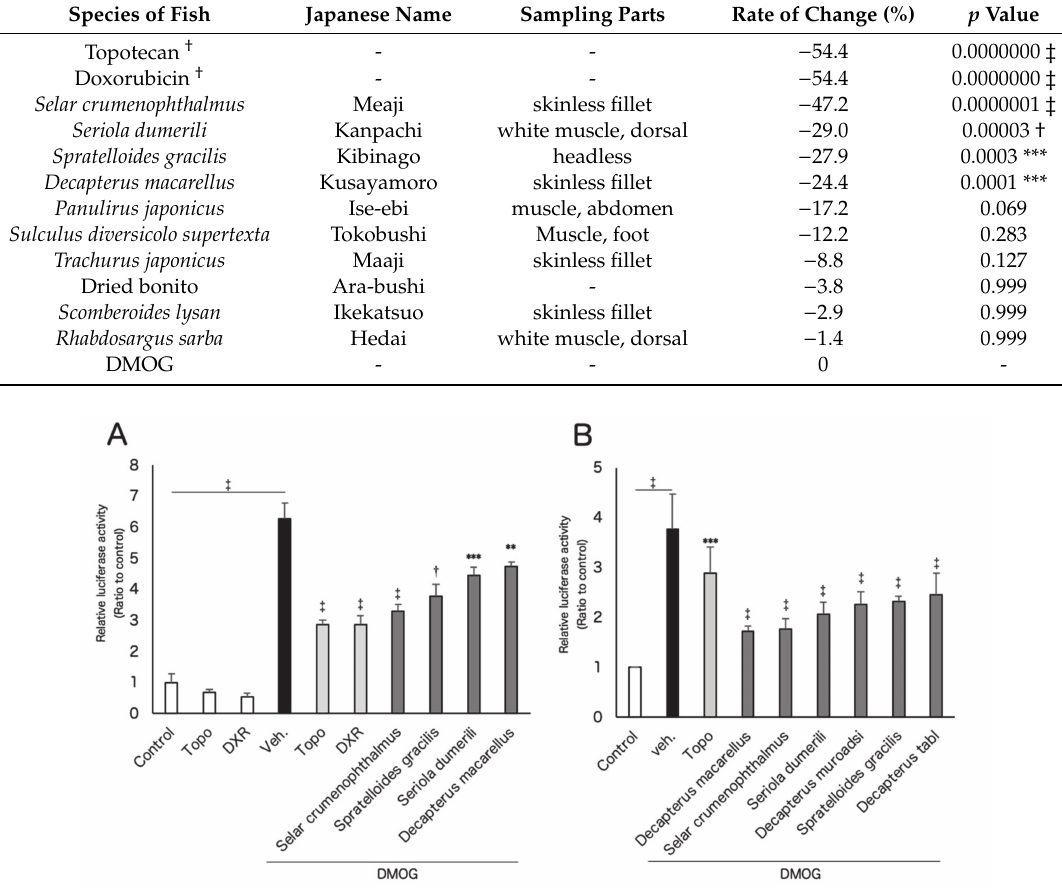
Figure 1. Fish ingredients show inhibitory e ff ects on hypoxia-inducible factor (HIF) activation in vitro. HIF-reporter luciferase assay was performed using the murine retinal cone cell line (661W) ( A ) and the human retinal pigment epithelium cell line (ARPE19) ( B ) cell lines ( n = 3). Topotecan, doxorubicin, and fish ingredients were administrated in dimethyloxalylglycine (DMOG)-induced culture conditions. Note that six species of fish ingredients significantly inhibited HIF activity induced by